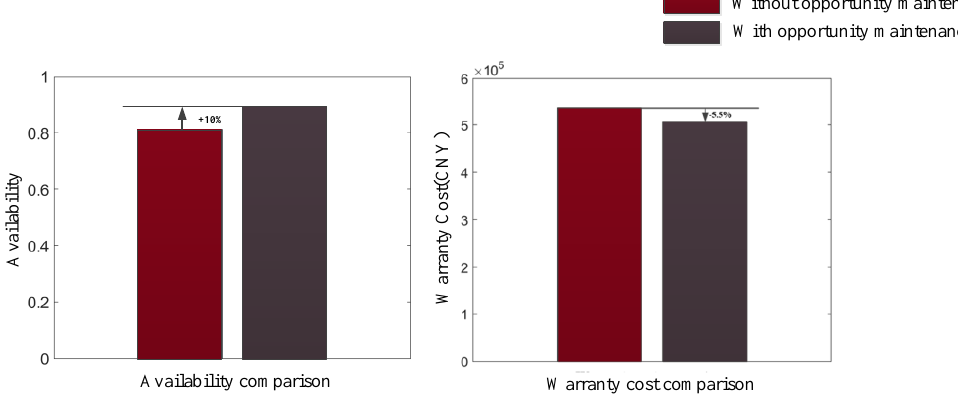
Figure 16. Comparison between situations with opportunistic maintenance and without opportunistic maintenance.